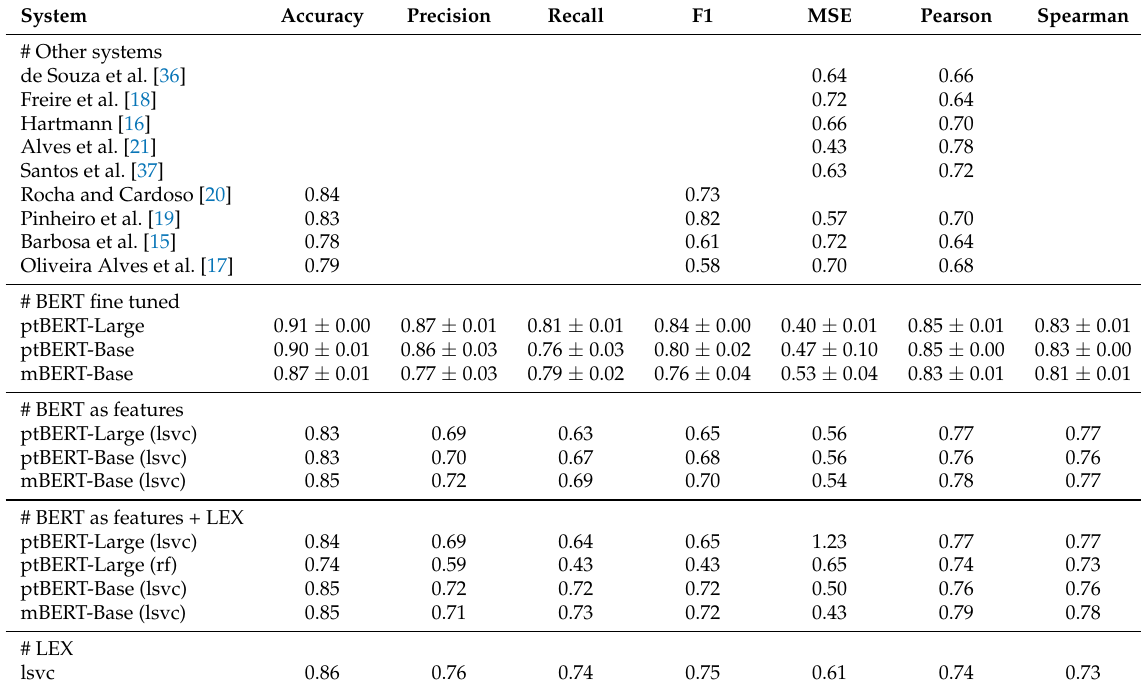
Table 1. ASSIN-PTPT NLI and STS results.